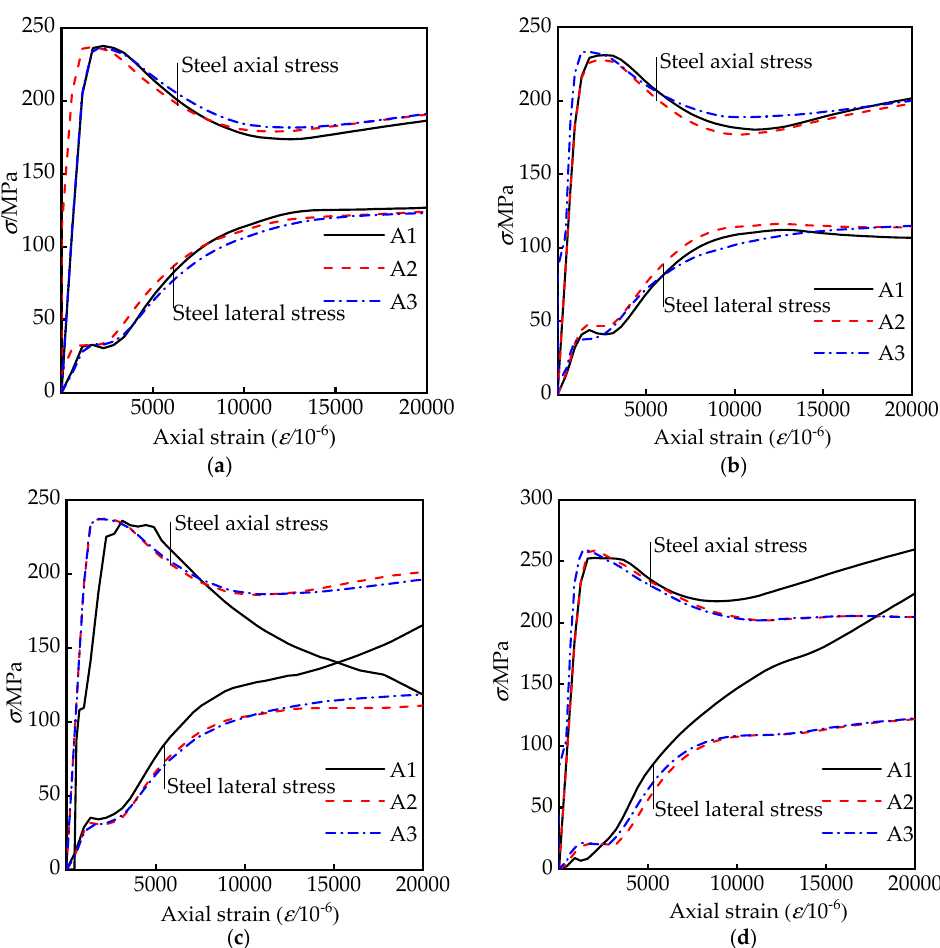
Figure 10. Comparisons of stress–axial strain curves of steel tube: ( a ) RRCFST-1; ( b ) RRCFST-3; ( c ) RRCFST-4; ( d ) RRCFST-13.